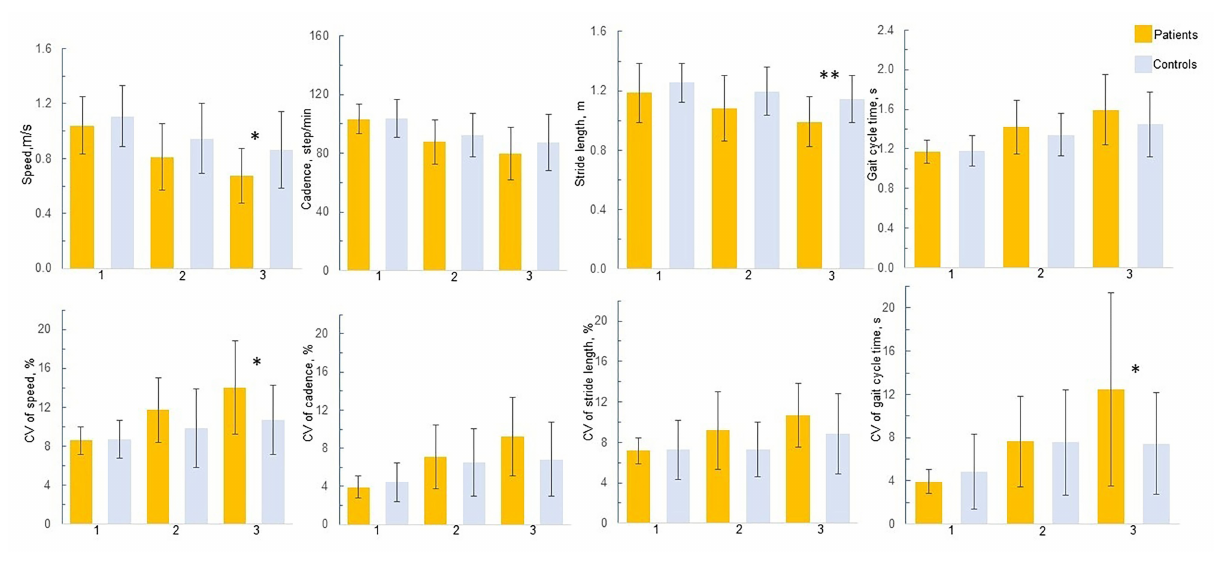
and walking while subtracting conditions (standing